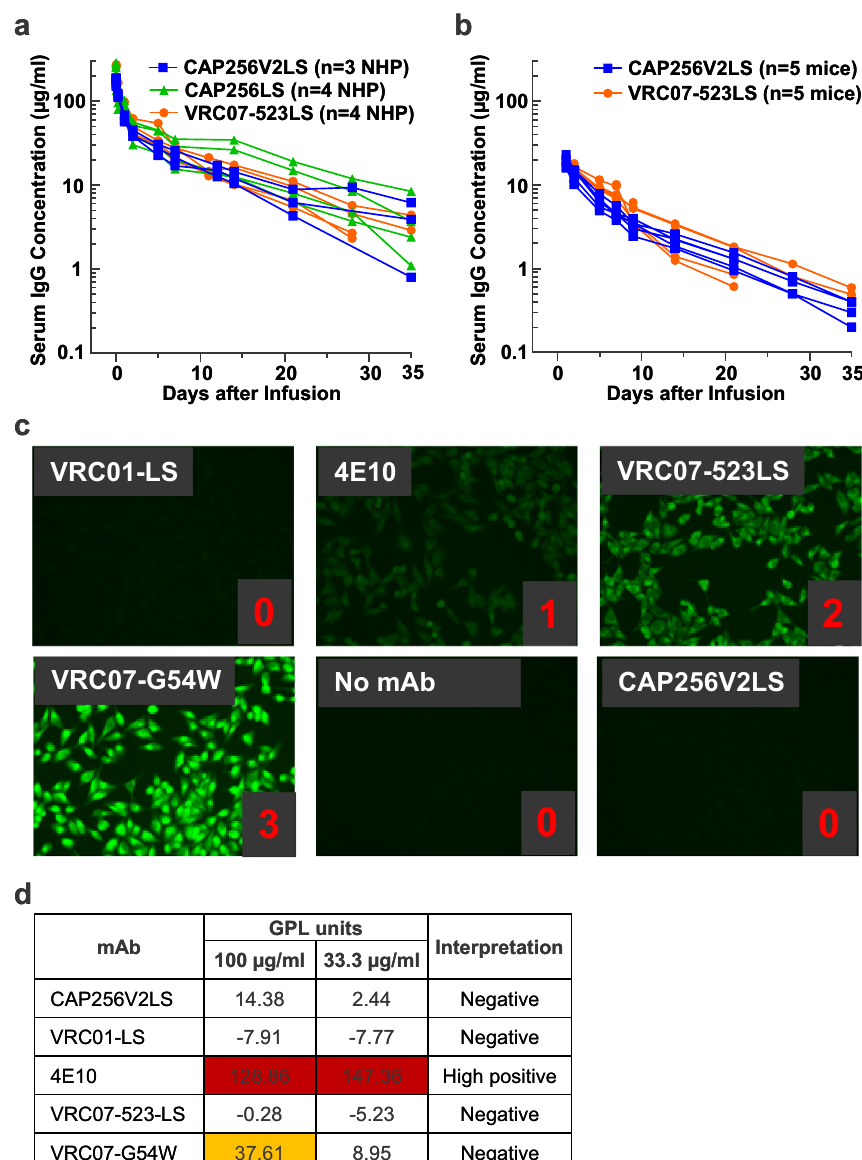
Figure 5. CAP256V2LS has a favorable pharmacokinetic (PK) profile in animal models and no autoreactivity in vitro. ( a ) PK in rhesus macaques (non-human primates, NHP). Naïve rhesus macaques were infused with 10 mg/kg of antibody, and the antibody concentrations were measured by an anti-idiotype based ELISA. Each line represents one animal. ( b ) PK in human FcRn mice. Naïve human FcRn mice were infused with 5 mg/ kg of CAP256V2LS or VRC07-523LS and antibody concentrations were measured by an anti-idiotype based ELISA. ( c ) Hep-2 cell staining. ( d ) Cardiolipin binding at 100 and 33 μg/ml inputs; values shown as GPL units. VRC01-LS, 4E10, VRC07-523-LS, and VRC07-G54W are included as controls in ( c,d